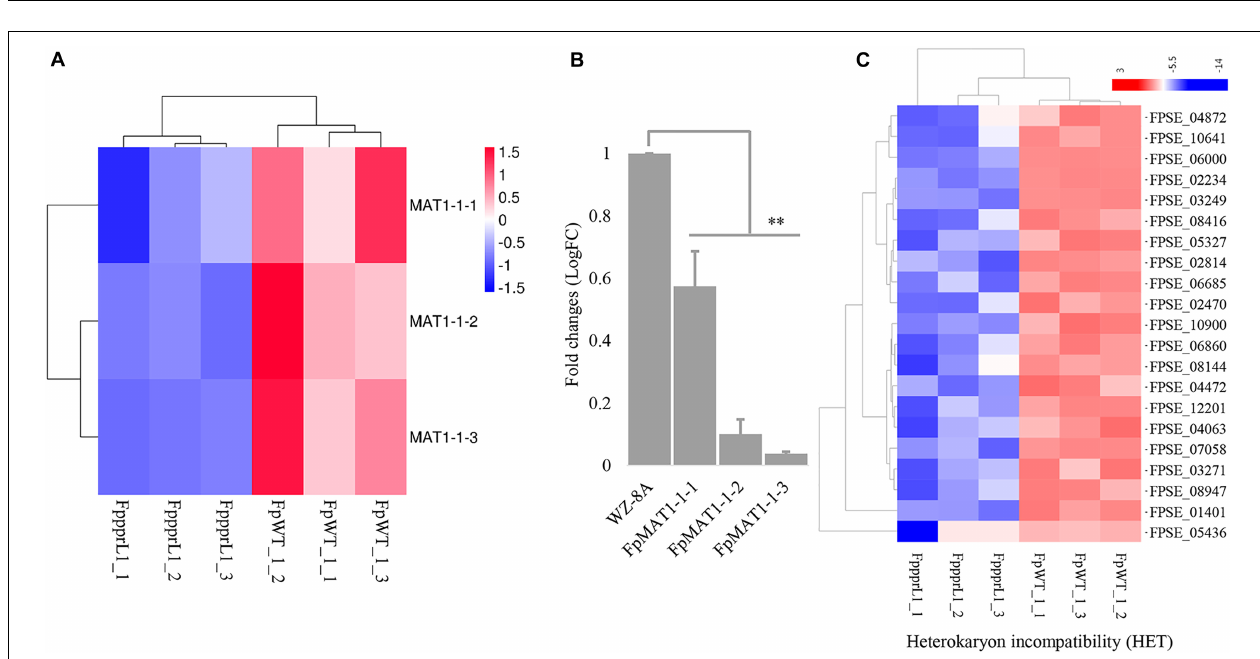
FIGURE 7 | Expression profiles of specific genes in the (cid:49) Fpppr1 mutant compared to wild type. (A) Expression profiles of specific genes for (cid:49) Fpppr1 and wild type strain WZ-8A in three biological replicates. The deferentially expressed genes (DEGs) were in log2 (fold change, FC) greater than 1.0 with a threshold at p-value and corrected p -value < 0.05 (False positive). (B) Heatmap for cytochrome P450 cluster. (C) Real time qRT-PCR for differentially down-regulated genes encoding oxidoreductases. First-strand cDNAs were synthesized using an RT-PCR kit as templates for qRT-PCR. The quantitative results are calculated and analyzed using the 2 − (cid:49)(cid:49) Ct method ( ∗ p < 0.05). FppprL1_1, FppprL1_2 and FppprL1_3 represent the sample names of the (cid:49) Fpppr1 mutant strain for RNA-seq. FpWT_1_1, FpWT_1_2, and FpWT_1_3 represent the samples names of wild type strain WZ-8A for RNA-seq.